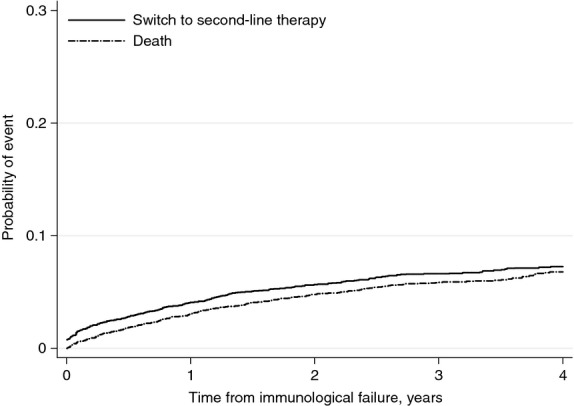
Probability of switch from first- to second-line ART or death, following immunological treatment failure. ART, antiretroviral therapy. Y-axis truncated at 0.3. Participants who changed therapy on the day of immunological failure were given 1 day of follow-up, so that they were included in the time-to-event analyses.